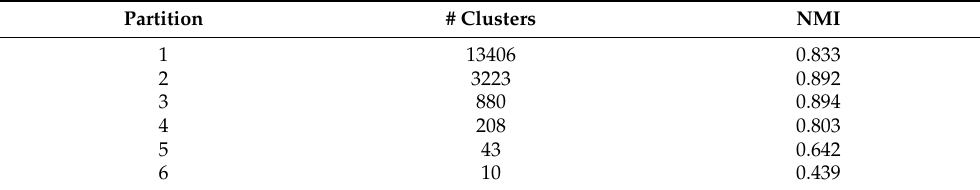
Table 10. Sensitivity of FINCH to Partition Selection. In this table, we show the NMI scores and the number of clusters of each FINCH partition. In our optimistic evaluation of Table 1, we manually selected partition three since the number of clusters of this partition is 880, which is the closest one to the ground-truth 1845. If we would not have the ground-truth but pick a random partition, the resulting NMI values could drop dramatically. In all experiments in this work, we always chose the FINCH partition closest to the ground-truth. Partition # Clusters NMI